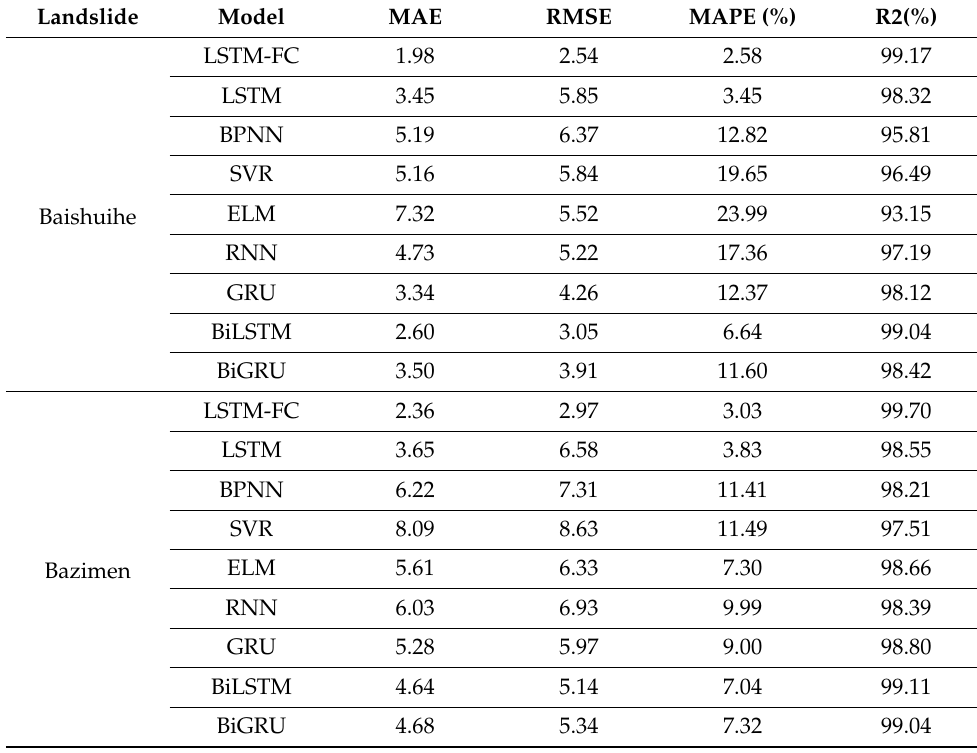
Table 2. Evaluation index results of each model for periodic displacement prediction. Landslide Model MAE RMSE MAPE